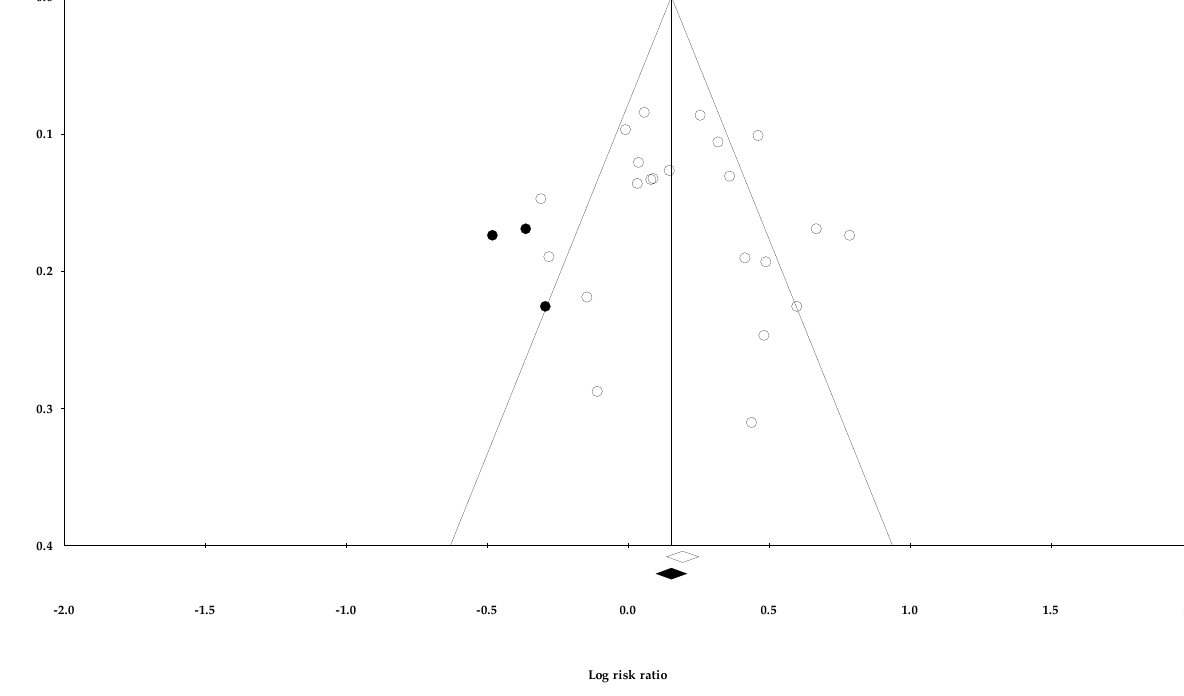
), imputed study ( • ), Figure 2. A funnel plot of the standardized mean difference in systolic blood pressure. Note: summary effect size ( ◇ ), (cid:51)